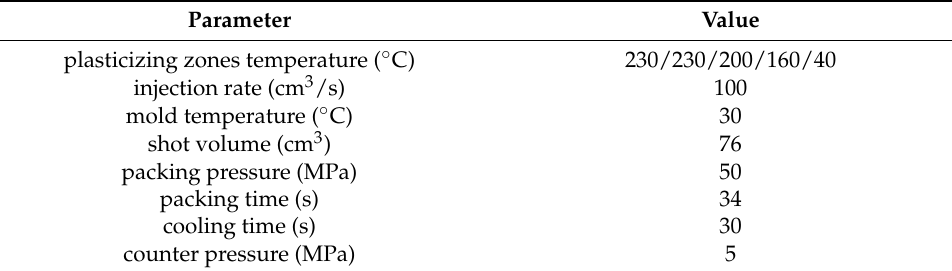
Figure 2. Geometry and basic dimensions of the print head nozzle. Table 1. The constant parameters of the injection molding process.